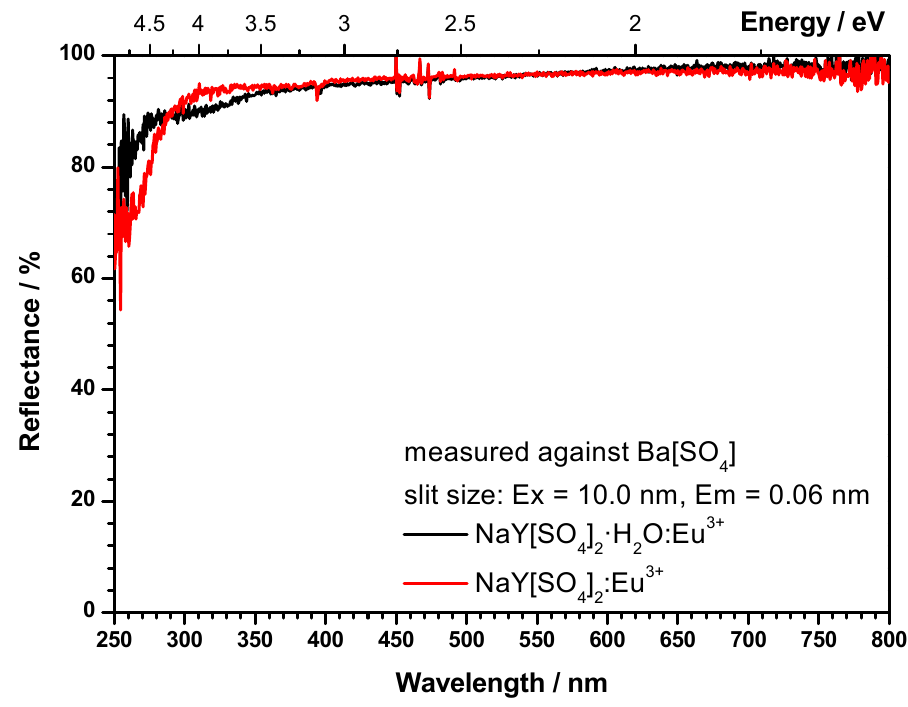
Figure 12. Reflection spectra of NaY[SO 4 ] 2 · H 2 O:Eu 3+ (black curve) and NaY[SO 4 ] 2 :Eu 3+ (red curve). Temperature-dependent excitation spectra of NaY[SO 4 ] 2 · H 2 O:Eu 3+ and NaY[SO 4 ] 2 :Eu 3+ reveal the typical intraconfigurational 4f–4f transitions of Eu 3+ between 280 and 550 nm [63,64] and the position of the LMCT of Eu 3+ in the anhydrous compound. The LMCT band was located at 270 nm and was in good agreement with the position derived from the reflection spectrum. The excitation spectra of both compounds are plotted in Figure